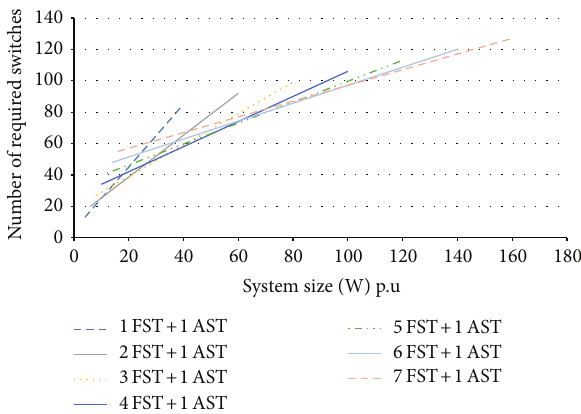
Figure 4: Configuration optimization flow chart according to system per unit and number of